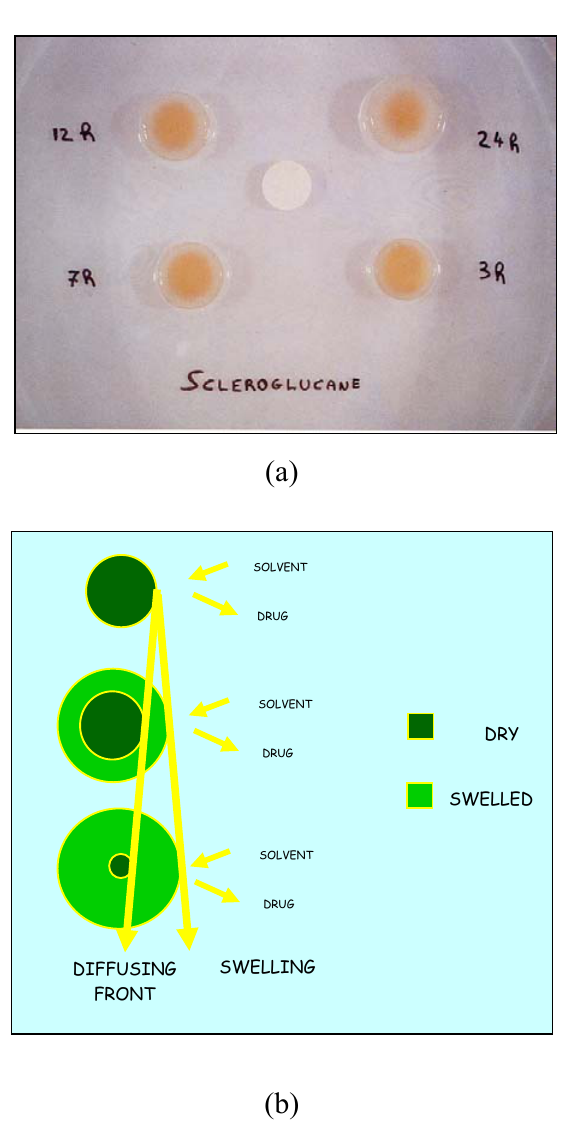
Scheme 2. (a) Photographs of 500 mg Sclg tablets taken after immersion of the tablet in a pH=2.0 solution for 3, 7, 12 and 24 h. The reference tablet (no immersion)